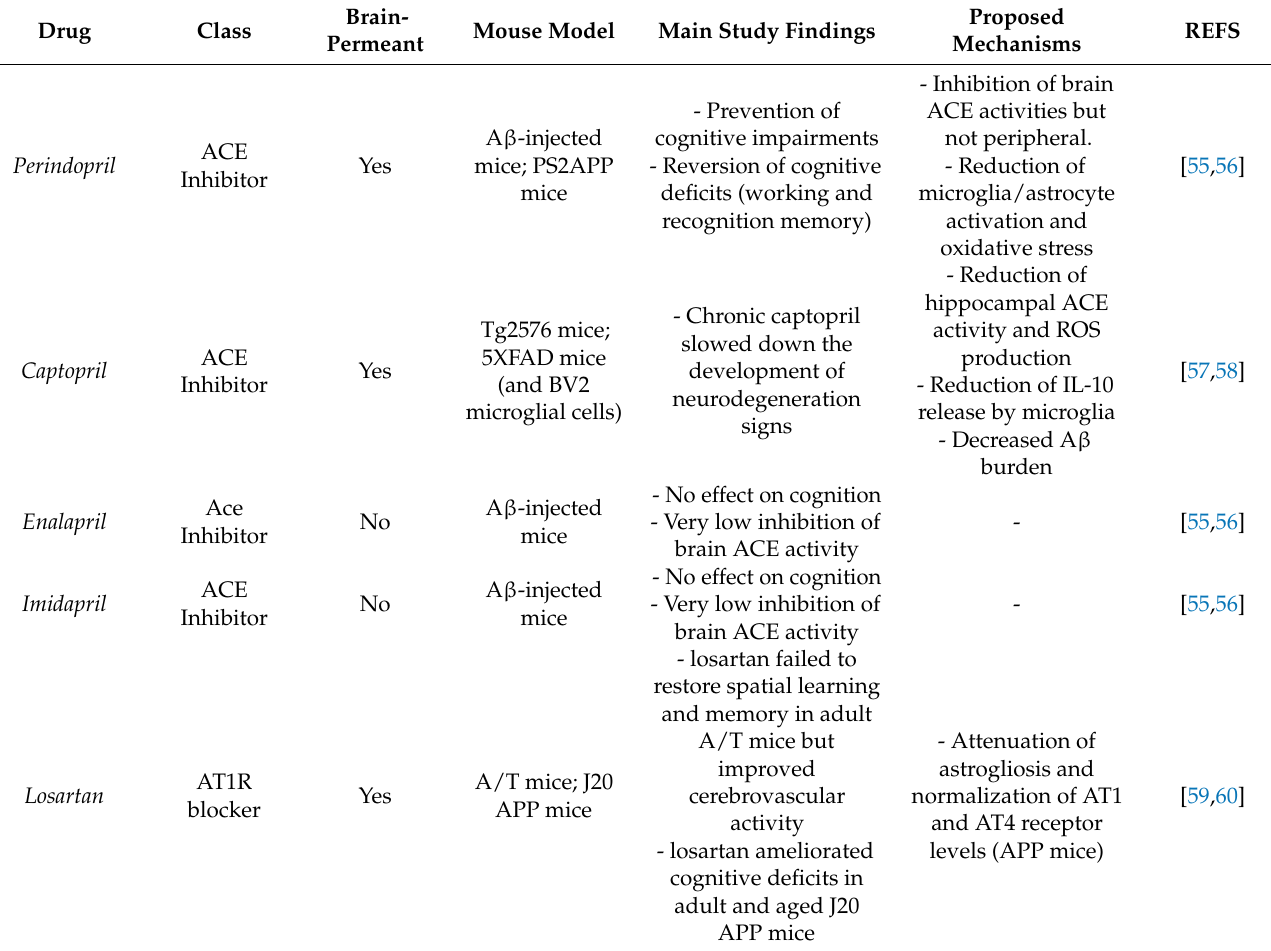
Table 1. RAS medications in mouse models